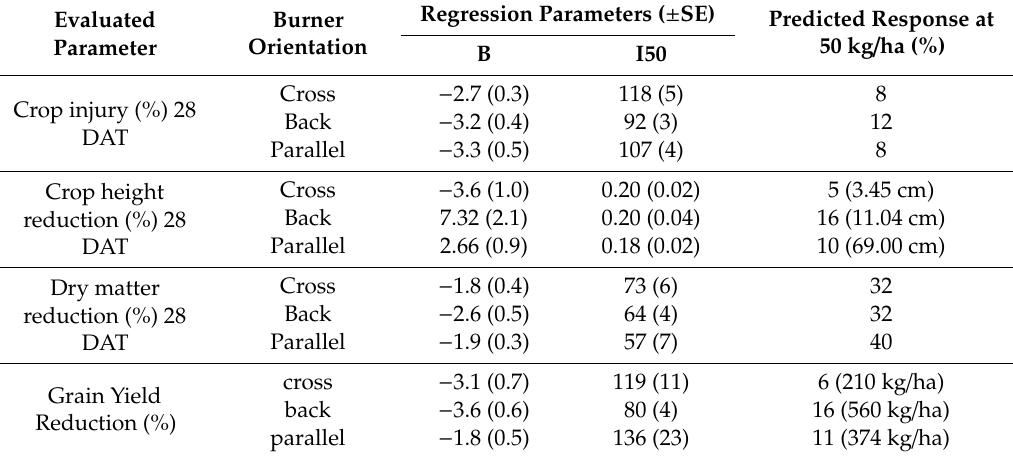
Table 2. Regression parameters ( ± SE) for the response of soybean crop injury (%) 28 days after treatment (DAT), crop height reduction (%) 28 DAT, dry matter reduction (%) 28 DAT, and grain yield reduction (%) as a ff ected by cross, back, and parallel burner orientation and dose of propane (0–100 kg / ha) (Figure 5). Predicted response of all evaluated parameters at 50 kg / ha propane dose are also included. Regression Parameters ( ± SE) Predicted Response at Burner Evaluated Orientation Parameter